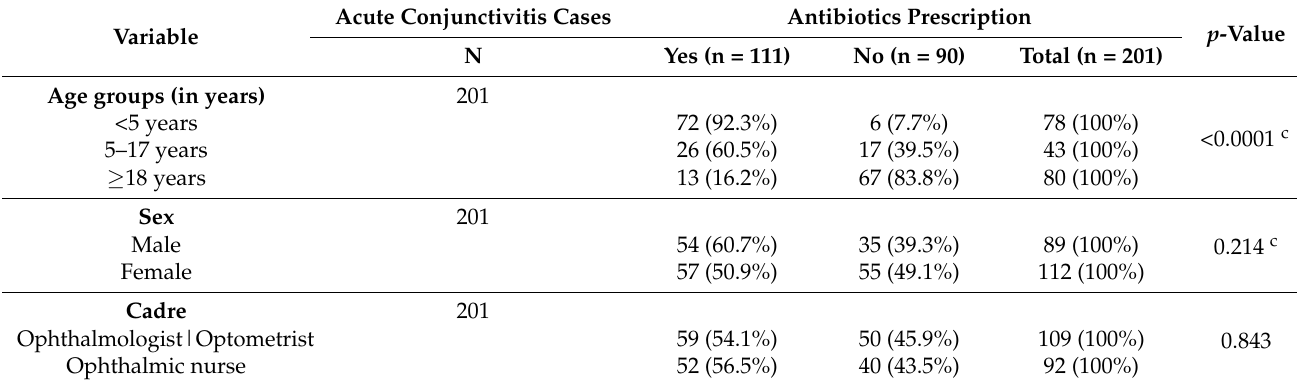
Table 3. Factors associated with antibiotic prescriptions in a specialist eye hospital in Ghana